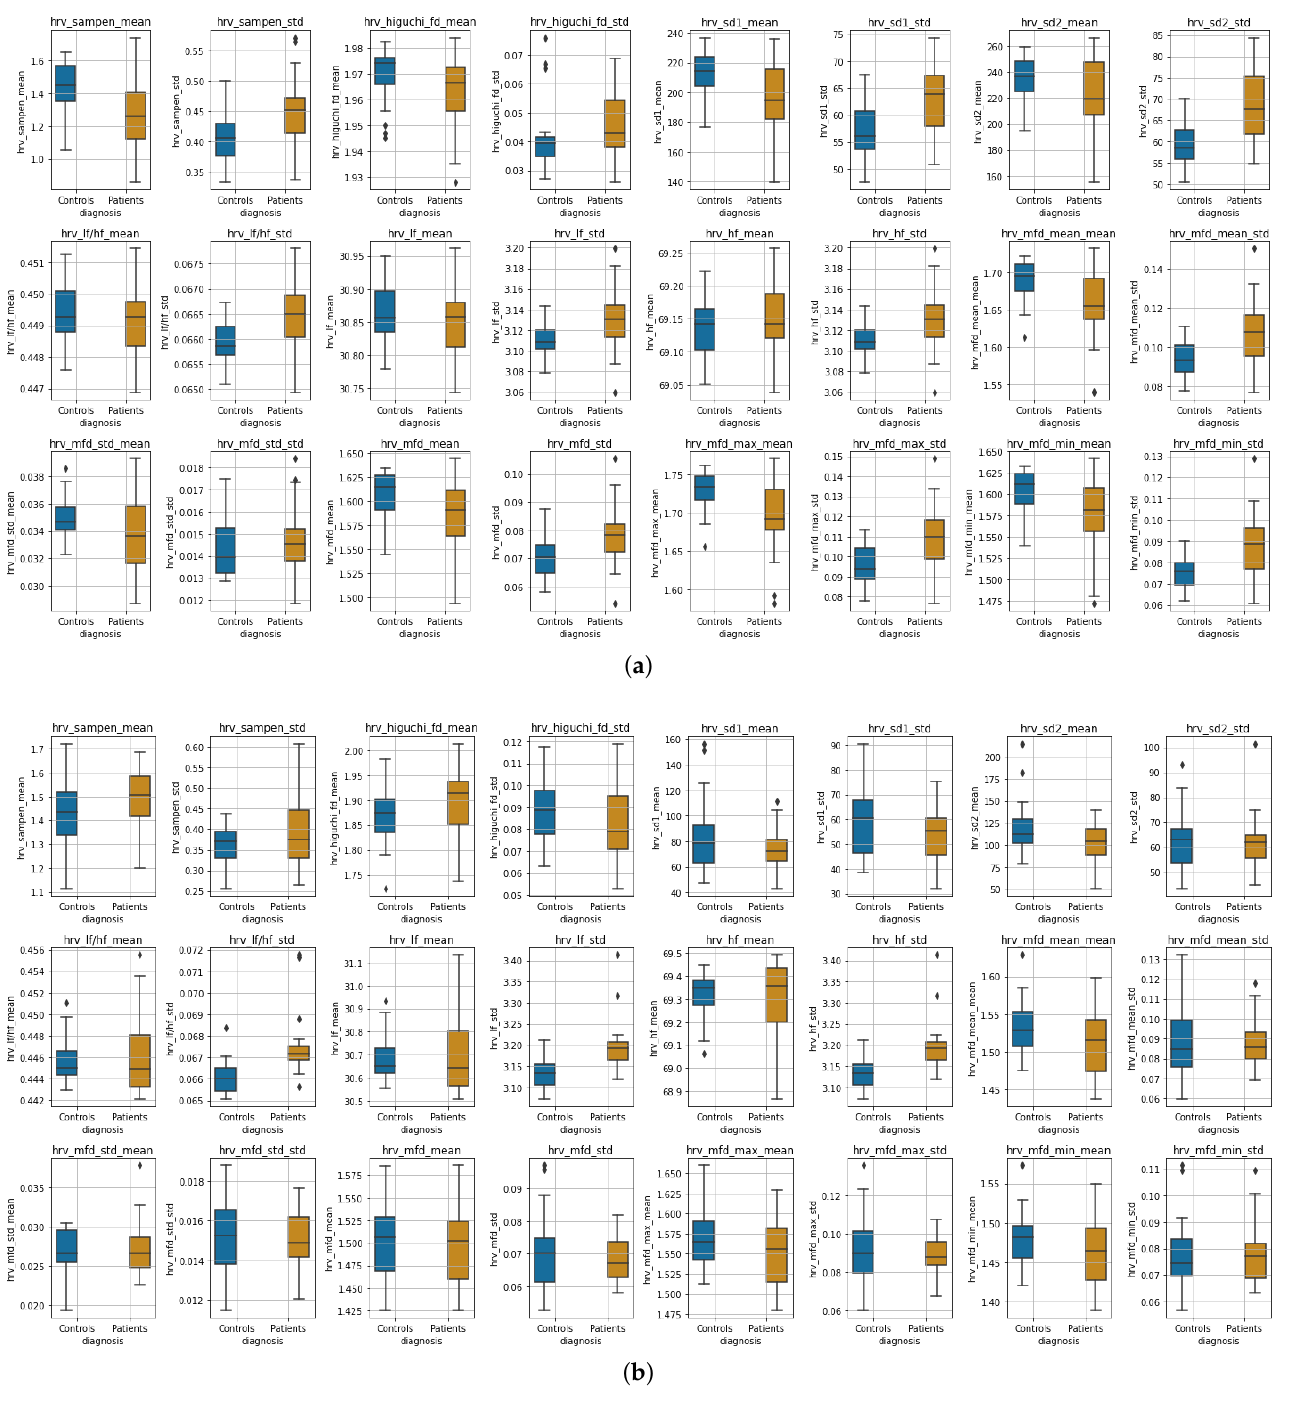
Figure 9. Boxplots for heart rate variability features of controls and patients while awake (top rows) and asleep (bottom rows). The bold line represents the median, the boxes extend between the 1st and 3rd quartile, whiskers extend to the lowest and highest datum within 1.5 times the inter-quantile range (IQR) of the 1st and 3rd quartile, respectively, and outliers are shown as diamonds. ( a ) Awake; ( b )